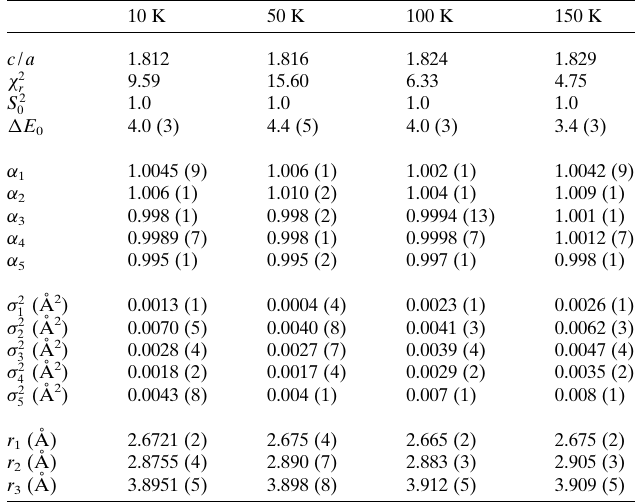
Figure 22 Fluorescence XAFS spectra in k 2 (cid:5) versus k and theoretical fits at ( a ) 10 K, ( b ) 50 K, ( c ) 100 K and ( d ) 150 K. The fit follows the data very closely, even below the fitting window. Table 4 Fitted parameters using fluorescent data sets; defined as for the transmission measurements, Table